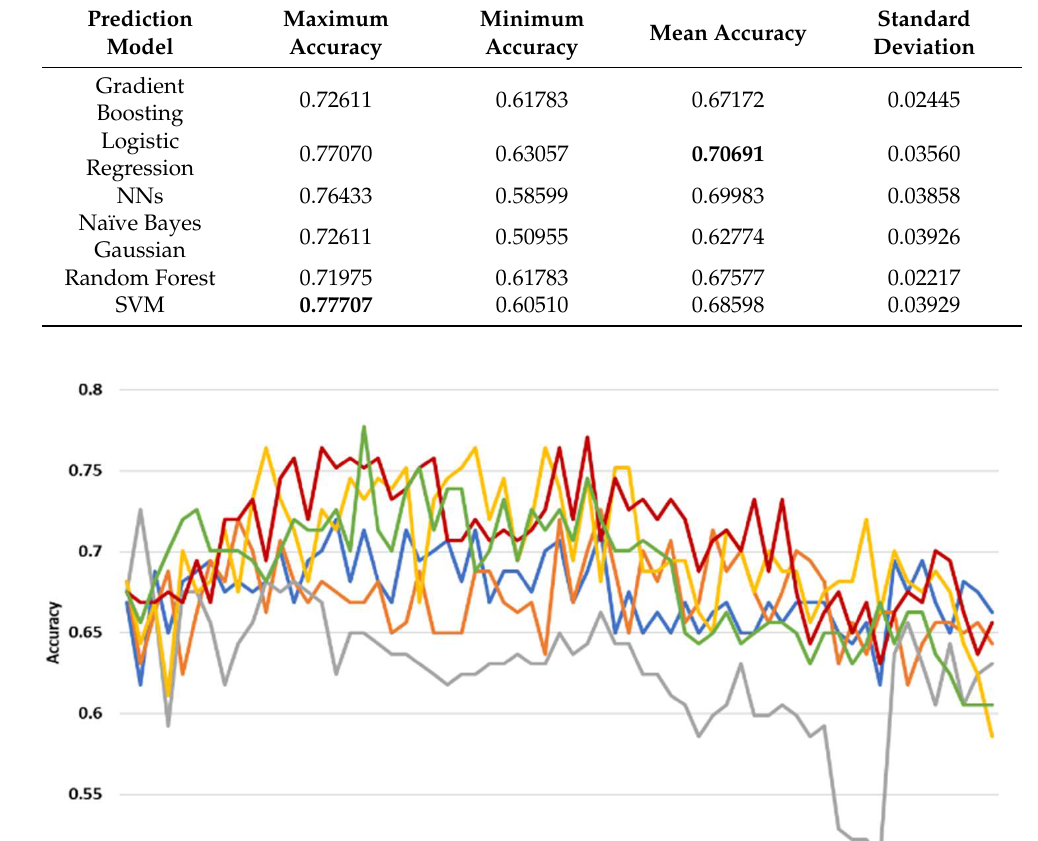
Table 7. Maximum, minimum, and mean accuracy of prediction models over the tested set for the right leg. The best results are indicated with bold.